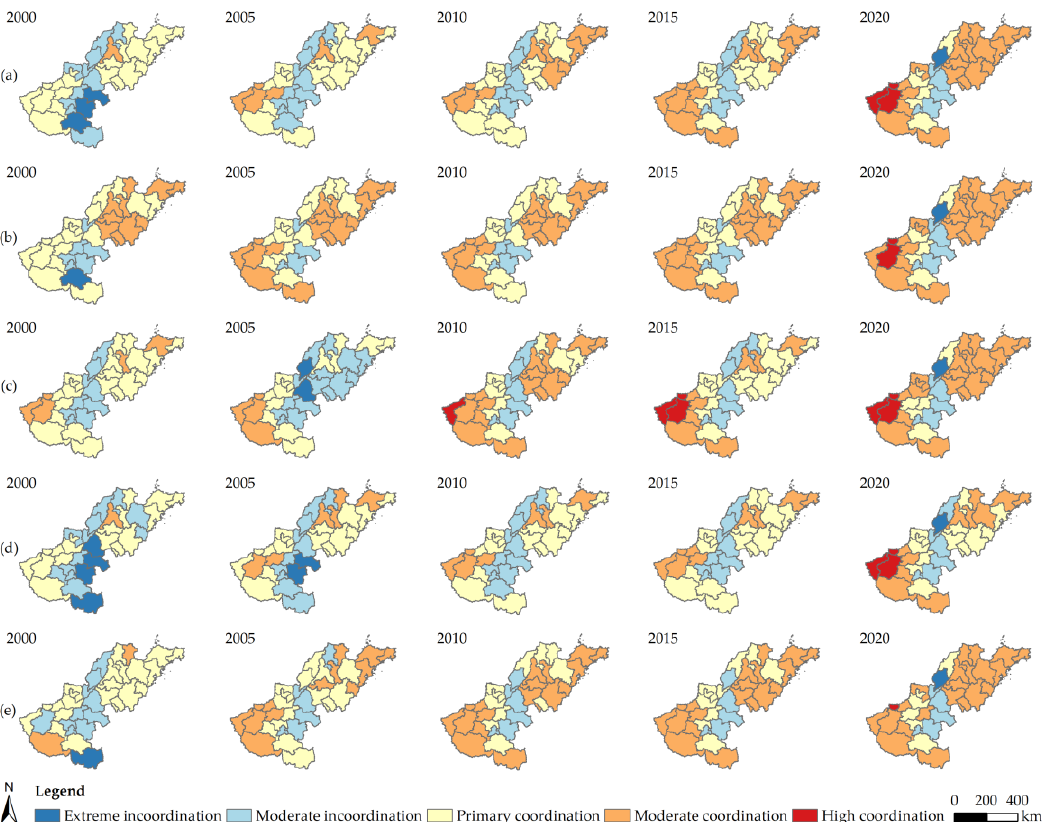
Figure 7. Coupling and coordination types of urbanization levels and subsystem urbanization levels with HQ for each city in the Lower Yellow River from 2000 to 2020: ( a ) urbanization level; ( b ) demographic urbanization level; ( c ) economic urbanization level; ( d ) social urbanization level; ( e ) spatial urbanization level.